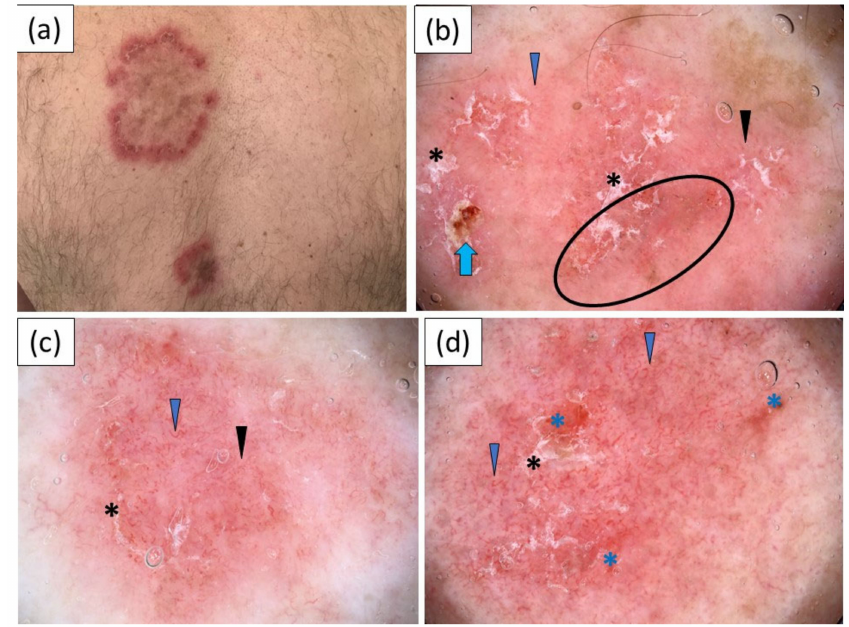
Figure 2. ( a ) Clinical presentation of subacute cutaneous lupus erythematosus (SCLE) on the back; ( b – d ) show videodermoscopic images: ( b ) videodermoscopy showing patchy white scales (black asterisk), erosion (blue arrow), scattered gray–brown dots/peppering (black circle), linear (blue arrow- head) and linear curved (black arrowhead) vessels on a pink–red background; ( c ) videodermoscopy showing discrete peripheral scaling (black asterisk) and abundance of linear (blue arrowhead) and linear branched (black arrowhead) vessels on pink background; ( d ) videodermoscopic findings: white scales (black asterisk), multiple linear, linear curved and linear branched vessels (blue arrowhead) on a pink–red background and red structureless (hemorrhagic) areas (blue